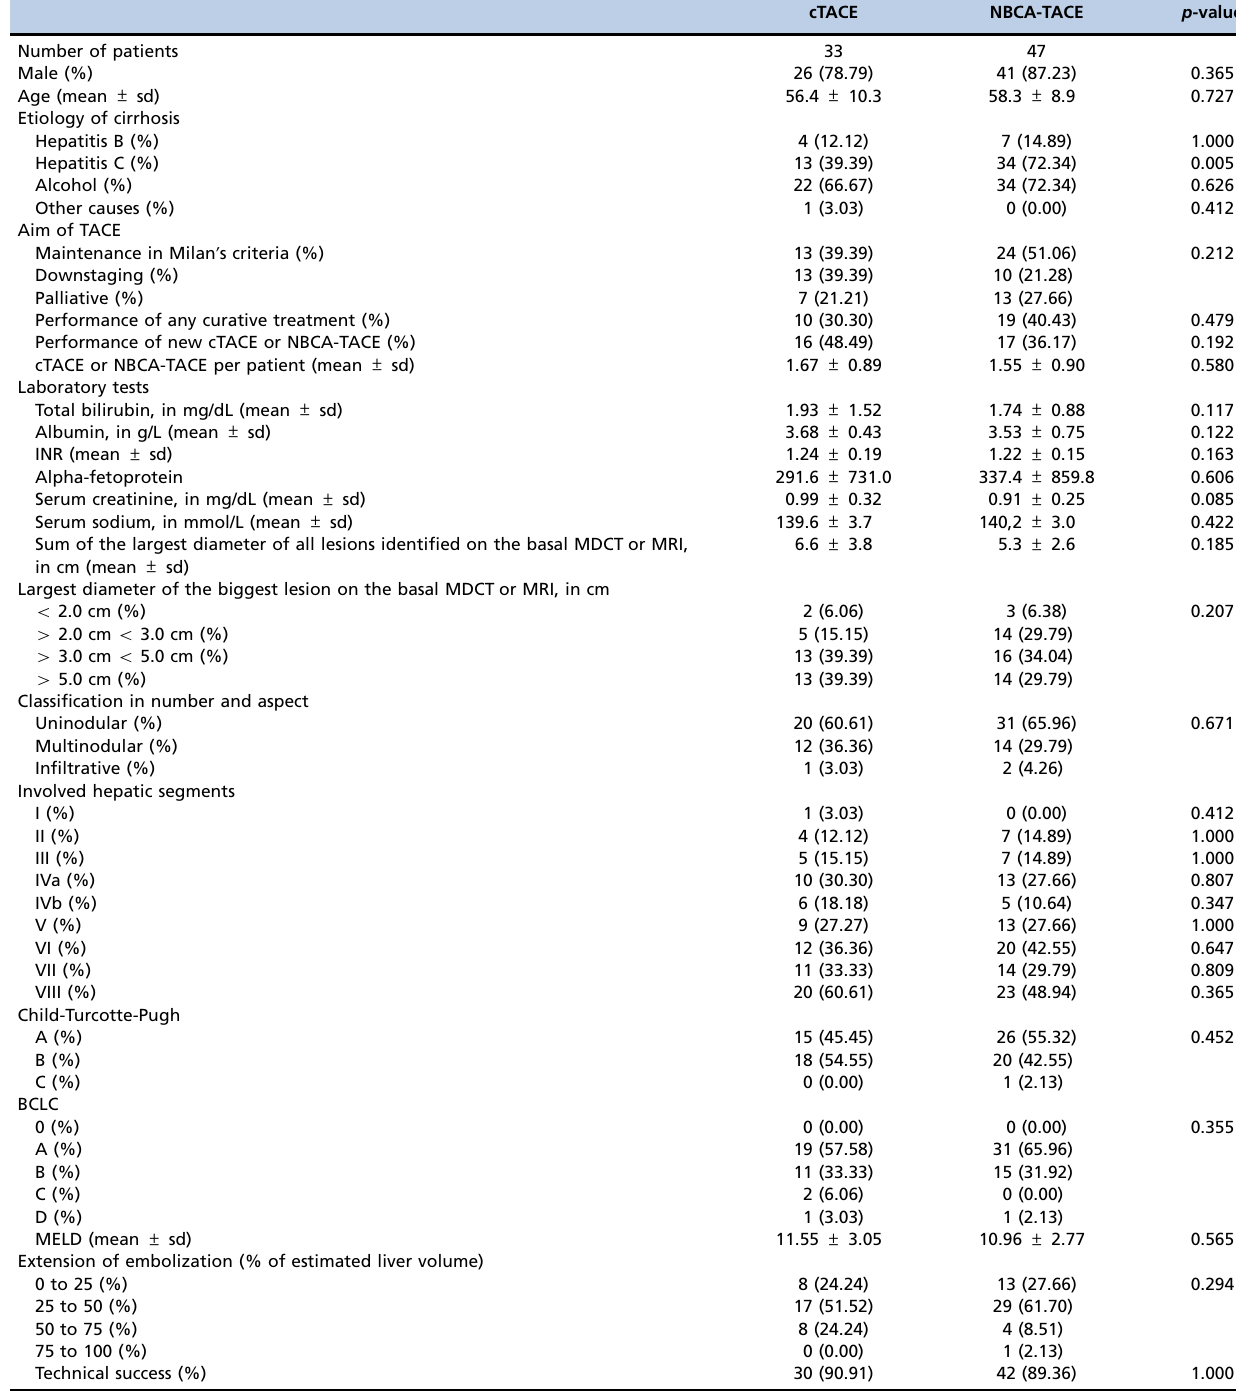
Table 1 - Baseline data of the